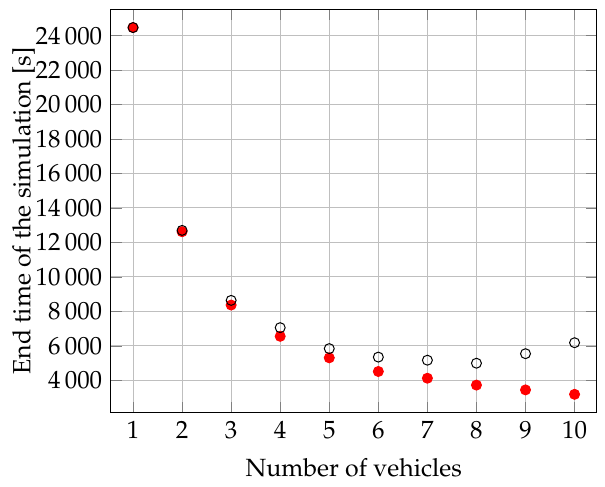
Figure 6. A comparison of the results for unidirectional paths.